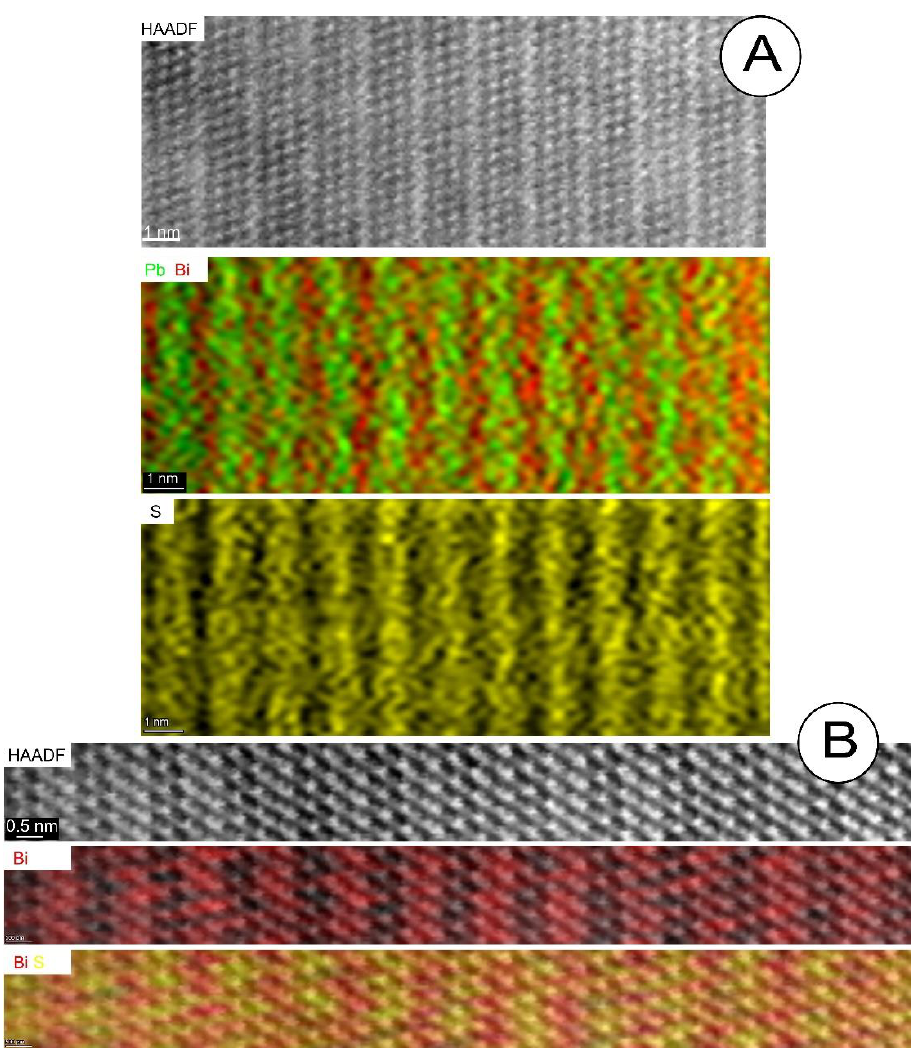
Figure 9. High-resolution STEM EDS element maps for ( A ) ikunolite and ( B ) joséite-A. The maps for ikunolite clearly show that Pb is located in the central parts of the layers and not substituted into the Bi–Bi pairs. The maps for joséite-A show the strongest Bi concentration overlaps with the marginal Bi2–Bi2 pairs, whereas S overlaps with the central part of the layers corresponding to a [Bi2–S–Bi1–Te–Bi1–S–Bi2] position topology. Although these element maps do not fully define the location of S between Bi2 and Bi1 atoms, the composition obtained from an integrated spectrum across the mapped area (Table 4) fits joséite-A stoichiometry closely.